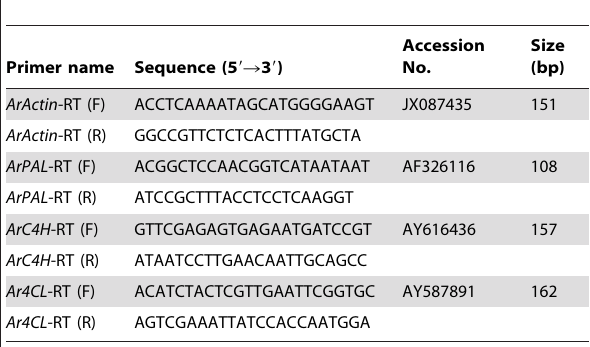
Table 1. List of real-time RT-PCR primers used in this study.